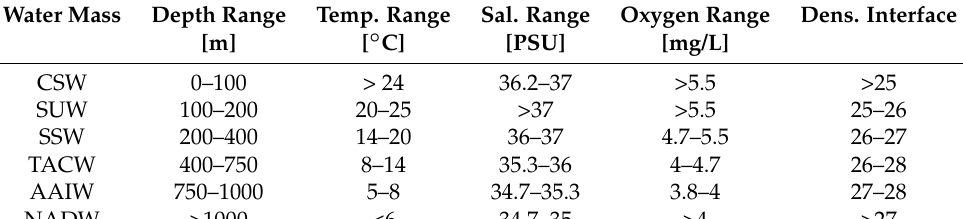
Table 3. Water masses and approximate range of their defining characteristics.